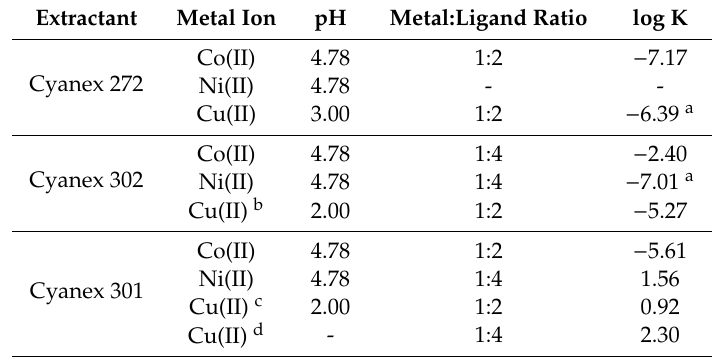
Table 3. Equilibrium constants for the extraction reaction